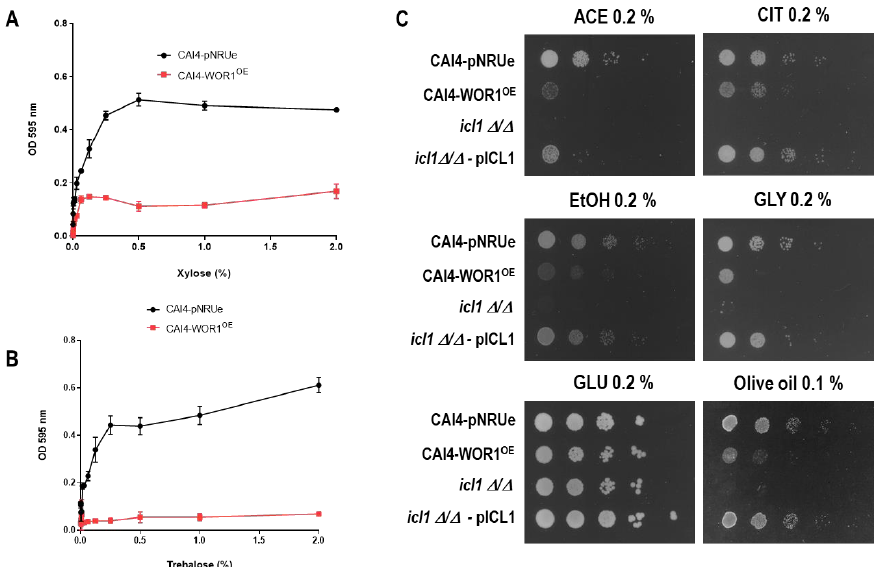
Figure 2. Comparative growth of strains in different carbon sources. Growth of pNRUe and WOR1 OE strains on MM medium supplemented with different concentrations of ( A ) xylose or ( B ) trehalose. The 96-well microtiter plates were incubated for 2 days (xylose) or 6 days (trehalose). Values are mean ± standard deviation of three independent replicates. ( C ) 10 5 cells and ten-fold dilutions from overnight growing cells from CAI4-pNRUe, CAI4- WOR1 OE , icl1 ∆ / ∆ , and icl1 ∆ / ∆ - pICL1 strains were spotted onto MM plates without amino acids and supplemented with 0.2% of sodium acetate (Ace), sodium citrate (CIT), ethanol (EtOH), glycerol (GLY), glucose (GLU), or olive oil. Plates were incubated at 37 ◦ C for 72 h before being